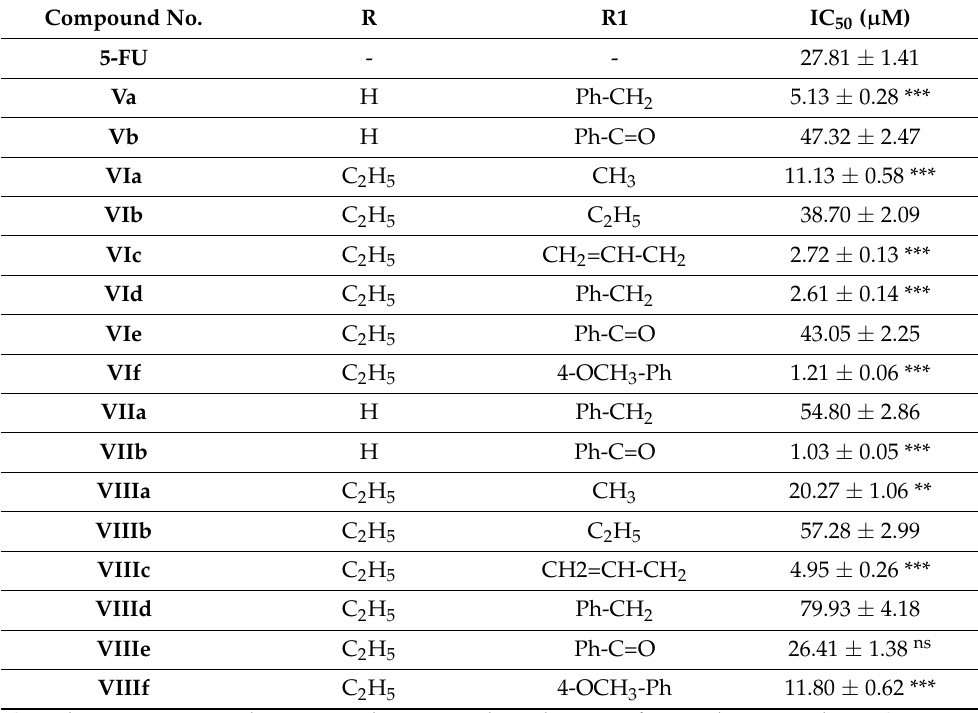
Table 1. The values of IC 50 ( µ M) of the tested compounds in MCF-7 cells. Compound No. R